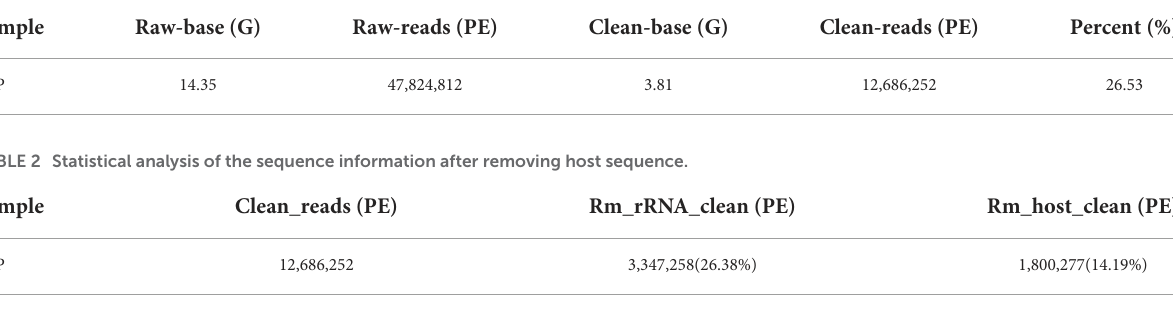
TABLE 1 Statistical analysis of the sequence information.